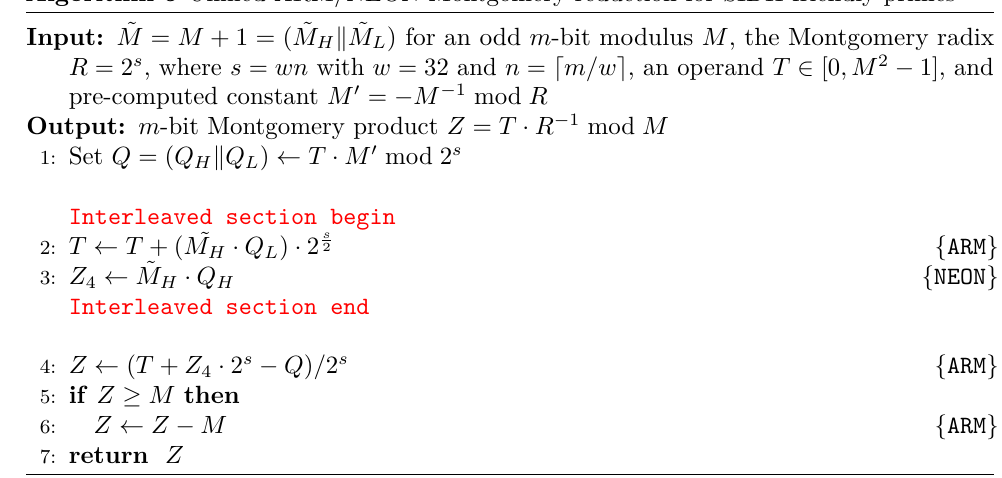
Algorithm 5 Unified ARM/NEON Montgomery reduction for SIDH-friendly primes